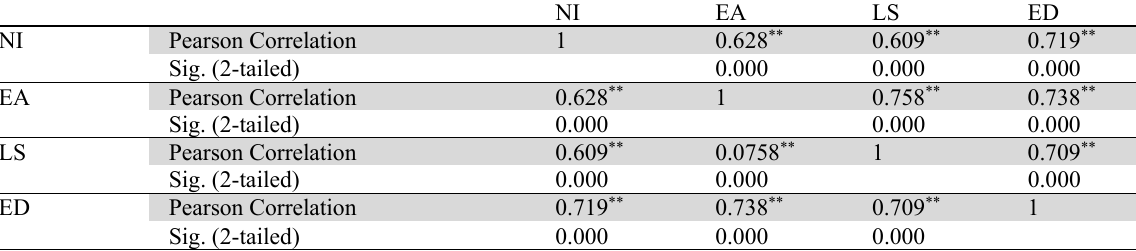
Correlation coefficients between